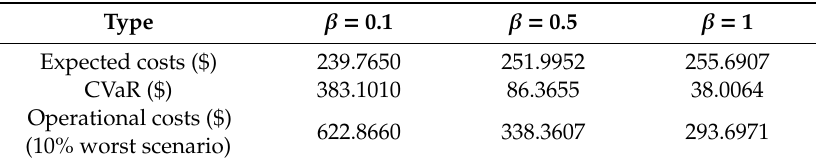
Table 5. Risk-based optimal operation according to β .